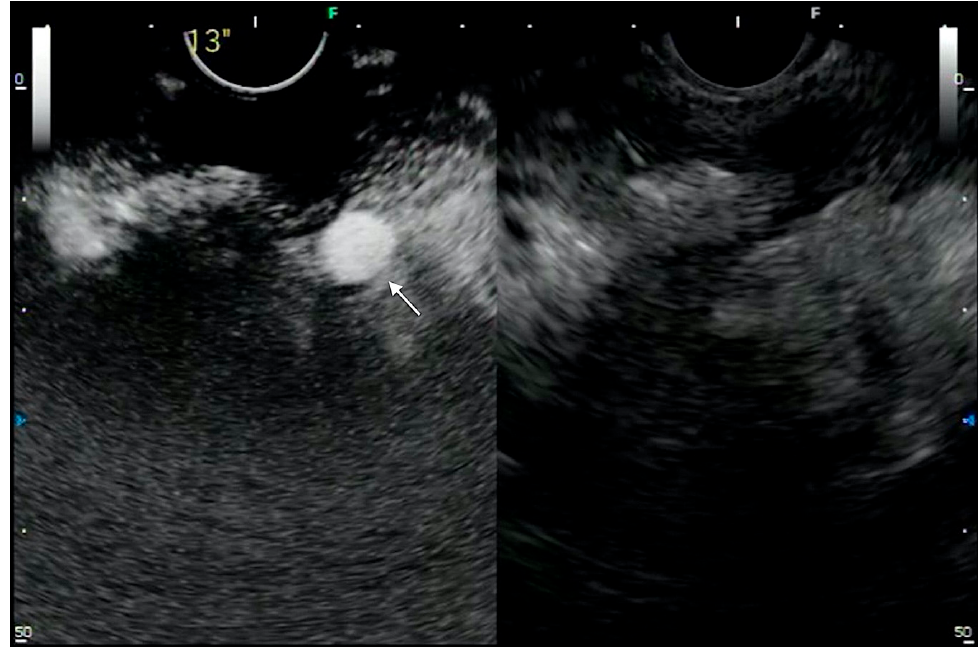
Figure 3. CH-EUS in PFC evaluation. View of splenic artery (arrow) within a walled-off pancreatic necrosis visualized using CH-EUS.